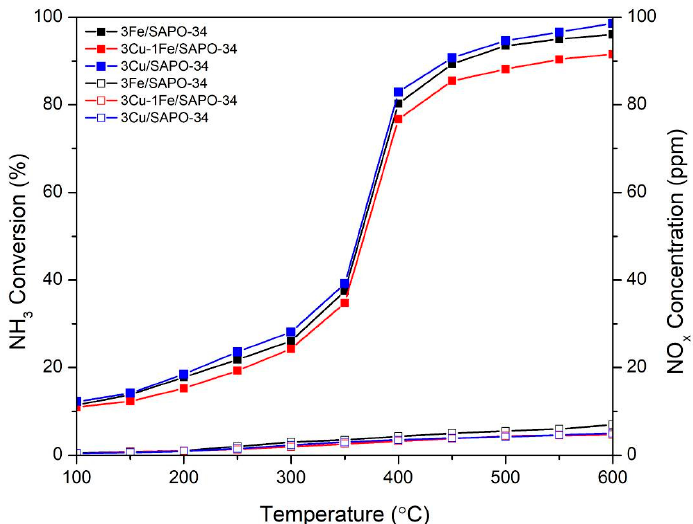
Figure 9 . NH 3 conversion (filled symbols) and NO x concentration (open symbols) as a function of temperature during the NH 3 oxidation experiment for the Cu/SAPO-34, Fe/SAPO-34, and Cu-Fe/SAPO-34 samples.